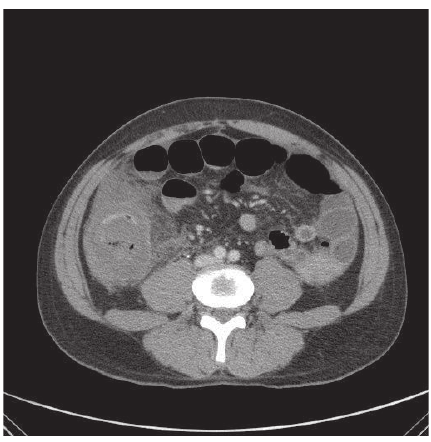
Figure 3: Coronal view and pelvic free fluid.